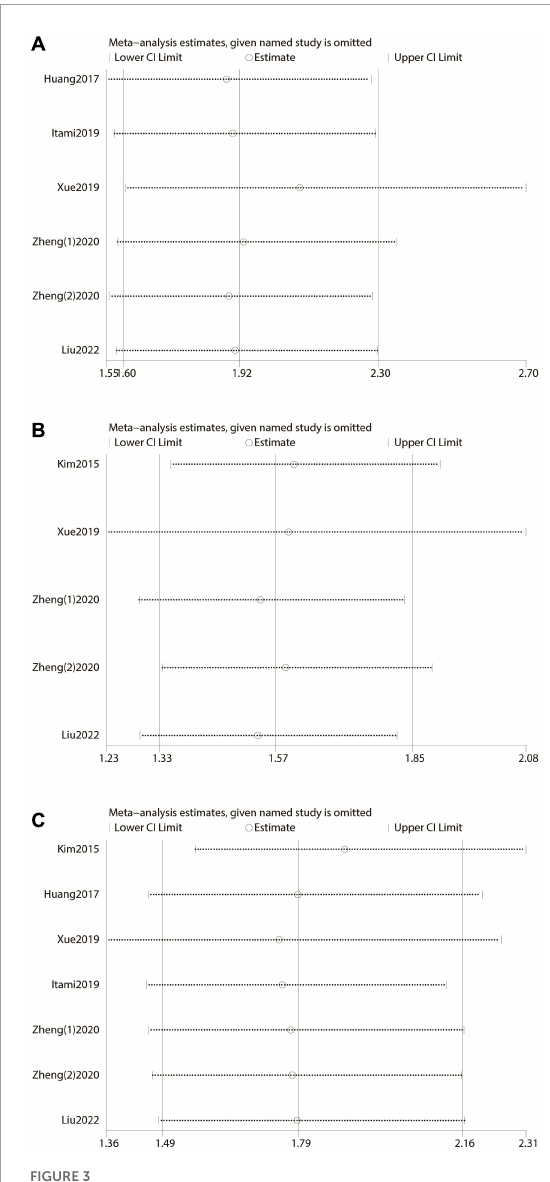
FIGURE3 Forest plot and sensitivity analysis. (A) Forest plot and sensitivity analysis of the relationship between over survival (OS) and prognostic nutritional index (PNI) score. (B) Forest plot and sensitivity analysis of the relationship between disease-free survival/recurrence-free survival/progression-free survival, and prognostic nutritional index score. (C) Forest plot and sensitivity analysis of the relationship between cancer-specific survival/disease-specific survival, and prognostic nutritional index score.